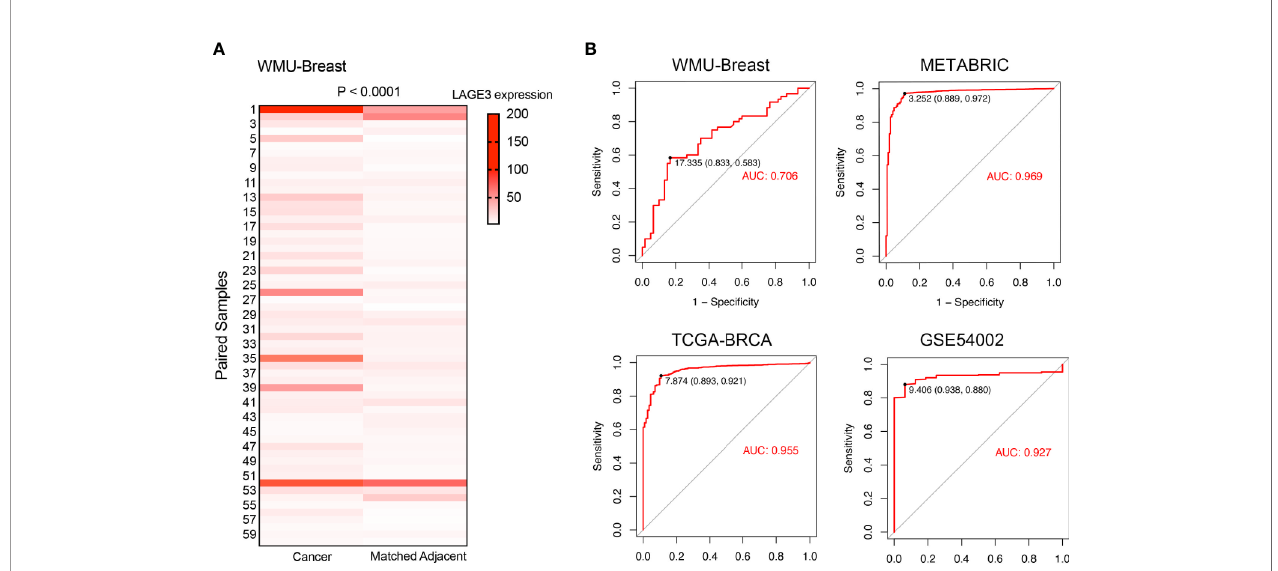
FIGURE 2 | LAGE3 was a potential diagnostic biomarker in BC. (A) LAGE3 expression in local BC tissues and paired normal breast samples as determined by qRT – PCR. (B) ROC curve showing the diagnostic value of LAGE3 in BC patients from the local cohort, METABRIC, TCGA, and GSE54002